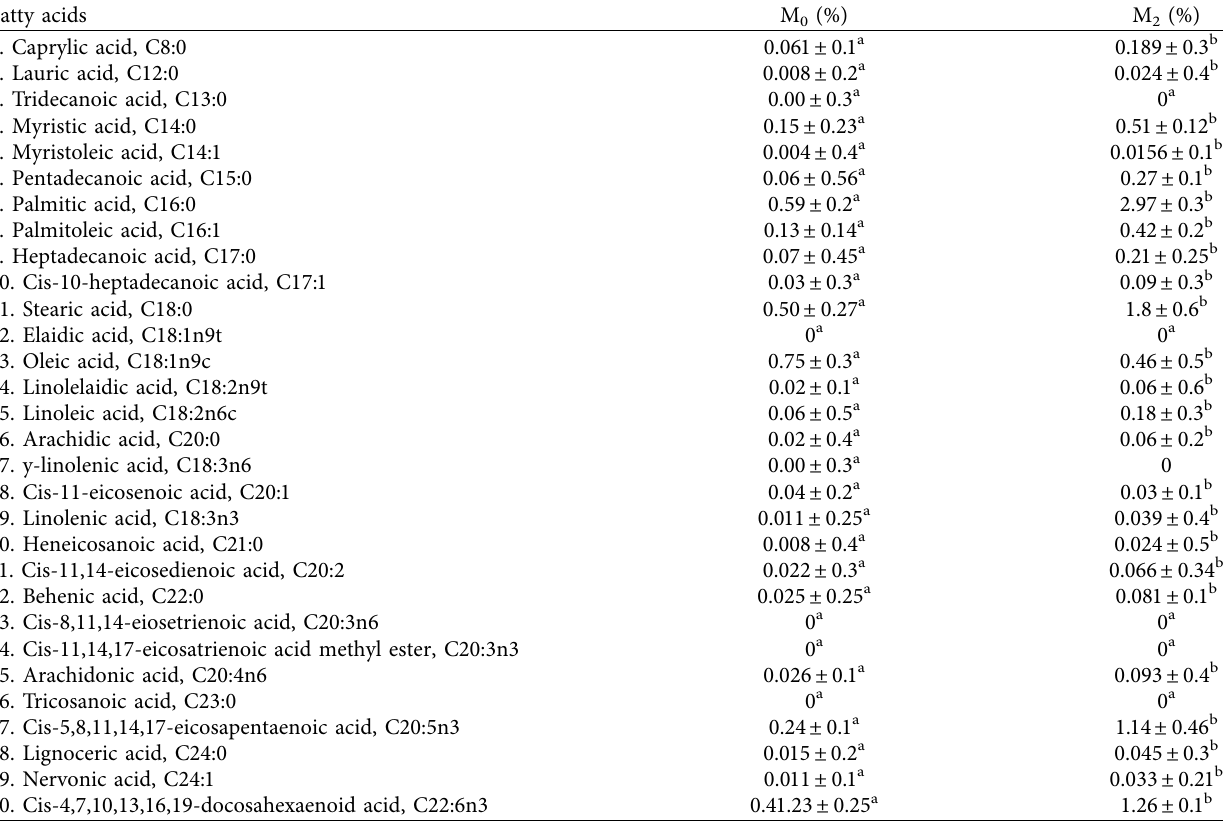
Table 6: The fatty acid content of sago